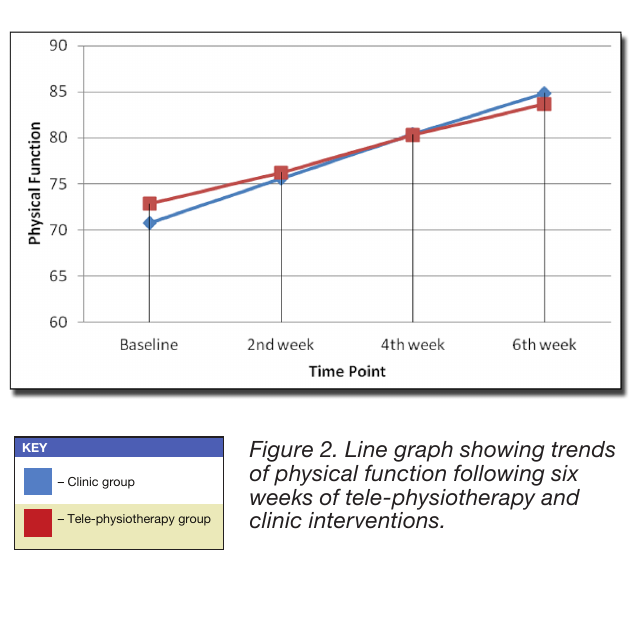
Figure 2. Line graph showing trends of physical function following six weeks of tele-physiotherapy and clinic